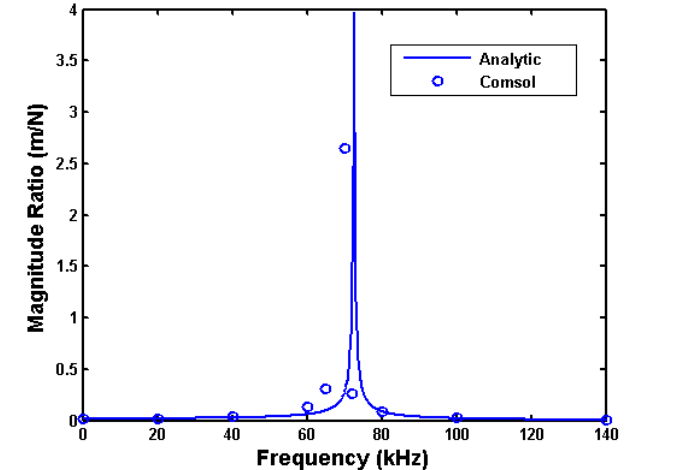
Figure 6. Comparison of analytical and numerical frequency responses for square plate with 67 μ m × 67 μ m hole, at ambient pressure of 300 Pa, with folded leg stiffness of 51.65